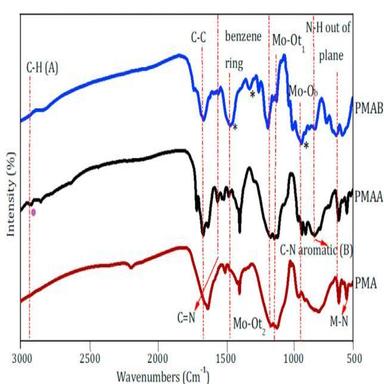
FT-IR spectral data of powder samples of silverton-type anion (PMA), silverton-type anion/Acetoguanamine (PMAA), and silverton-type anion /benzoguanamine (PMAB).